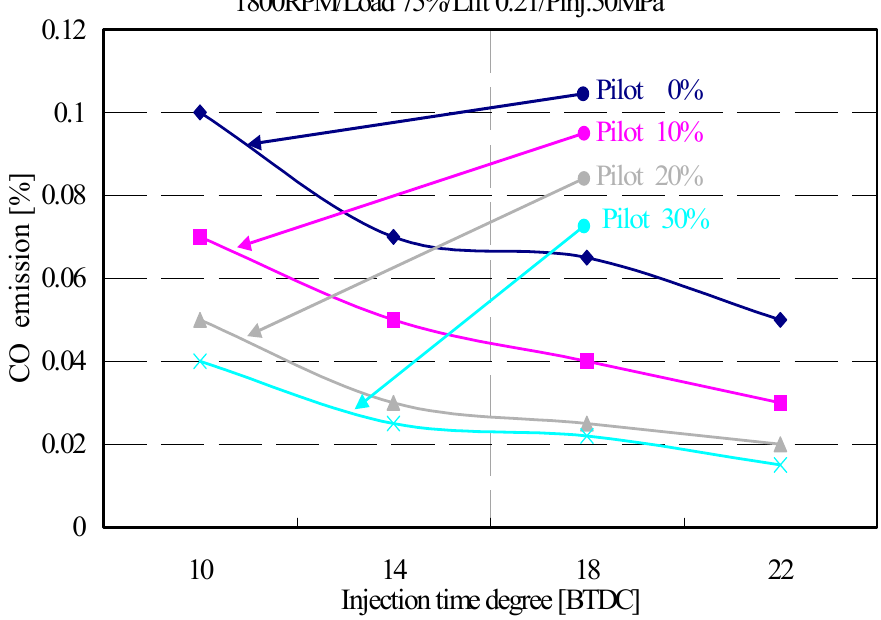
Figure 13. CO emission characteristics of DME engines with the pilot injection duration rate as a function of injection timing.